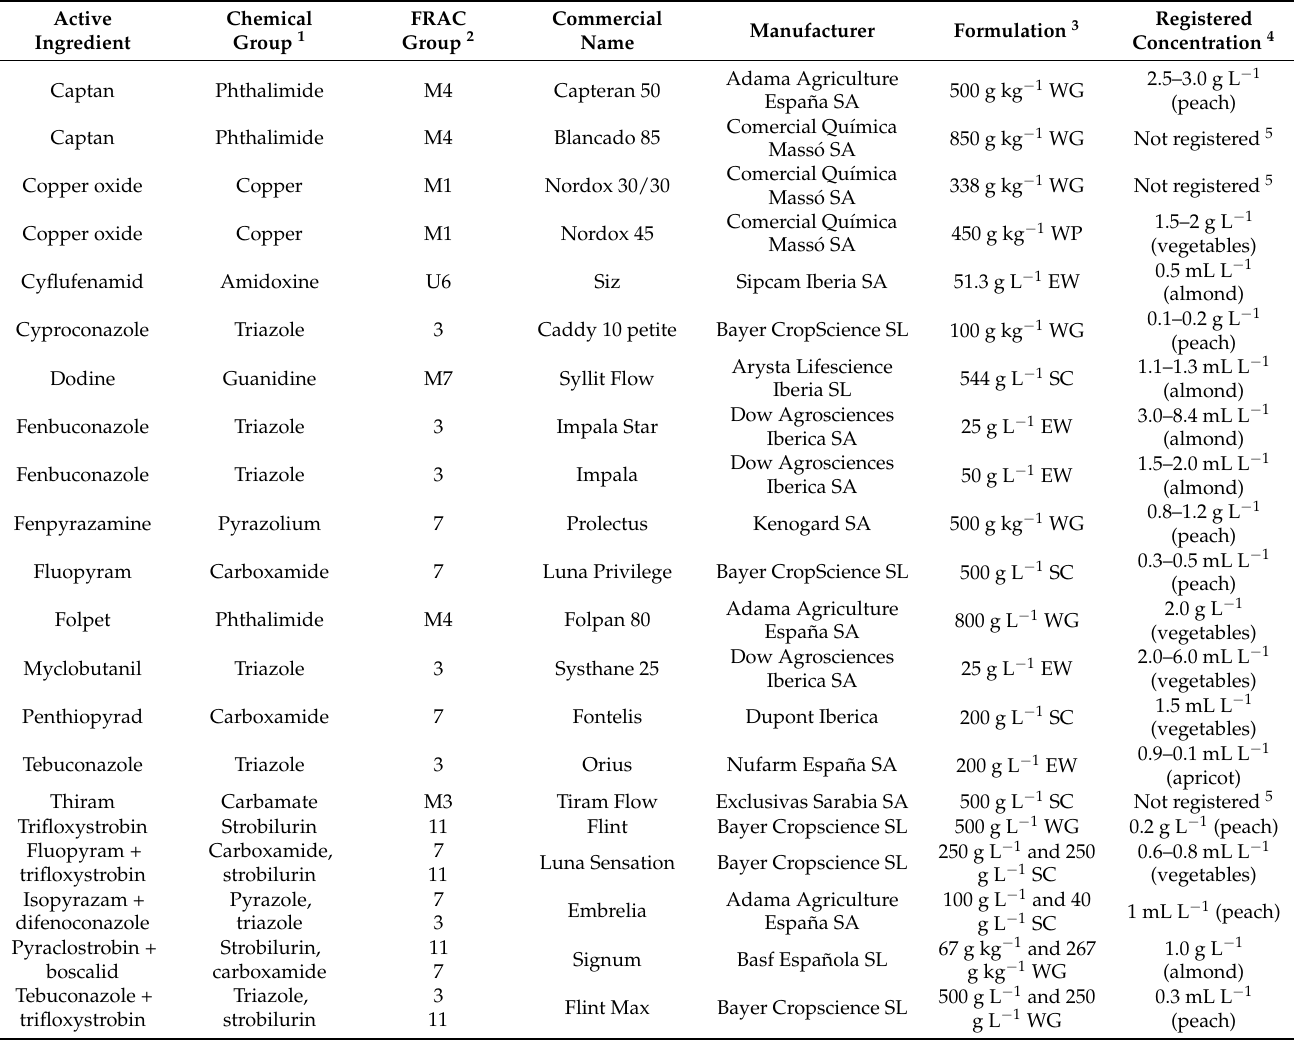
Table 1. Fungicide products evaluated for the control of the almond red leaf blotch between 2015 and 2019 in the Lleida region,